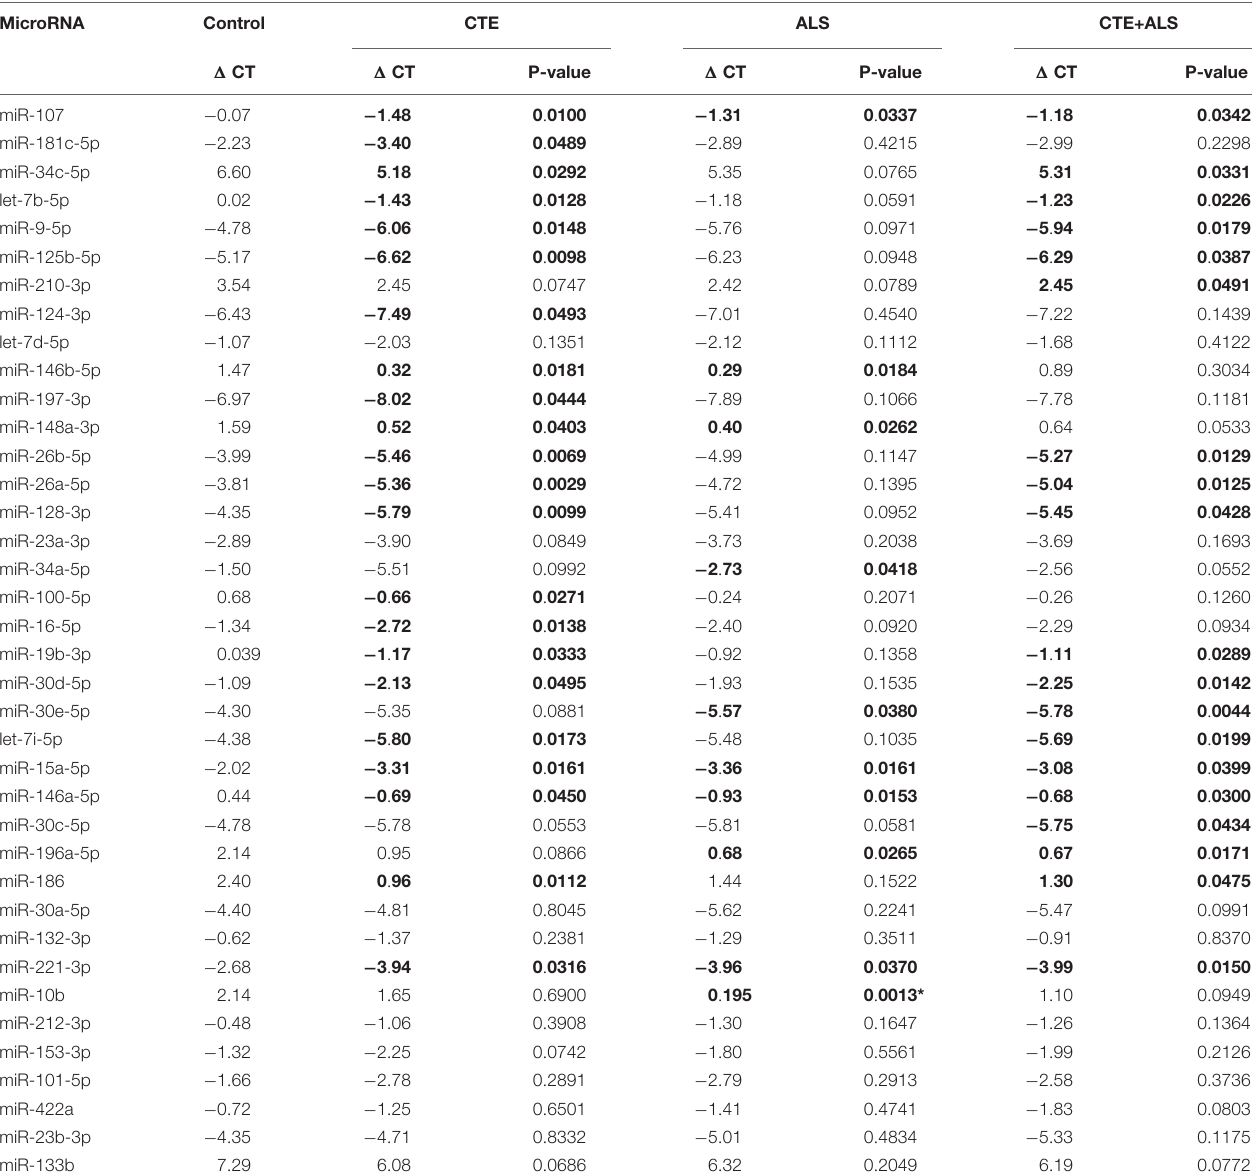
TABLE 2 | Changes in miRNA expression between pathological